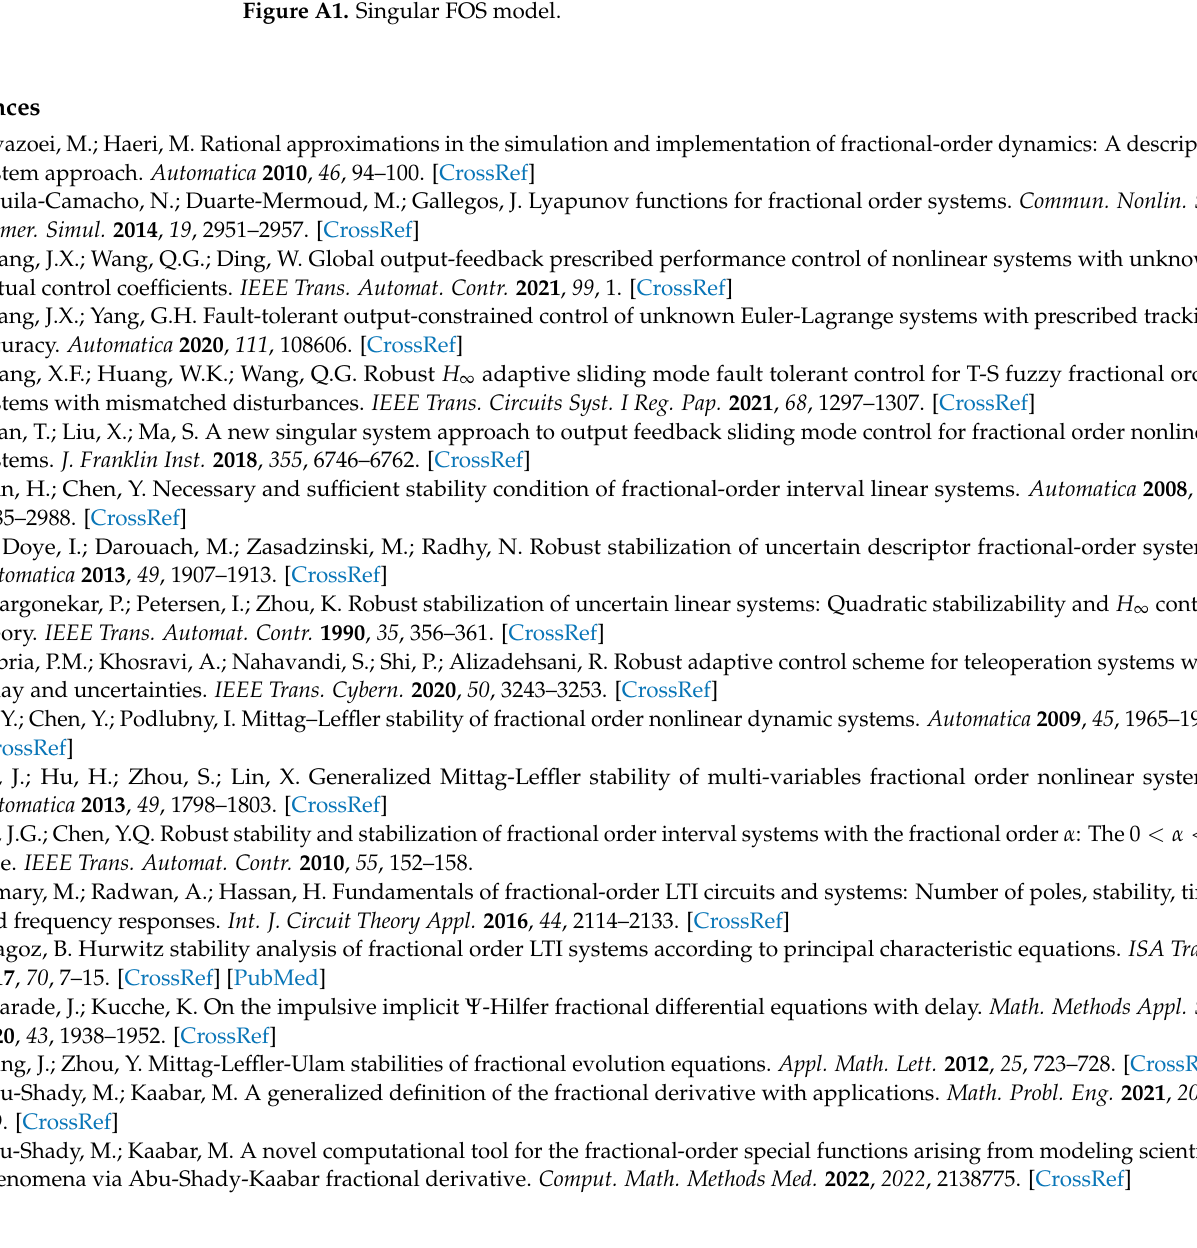
Figure A1. Singular FOS